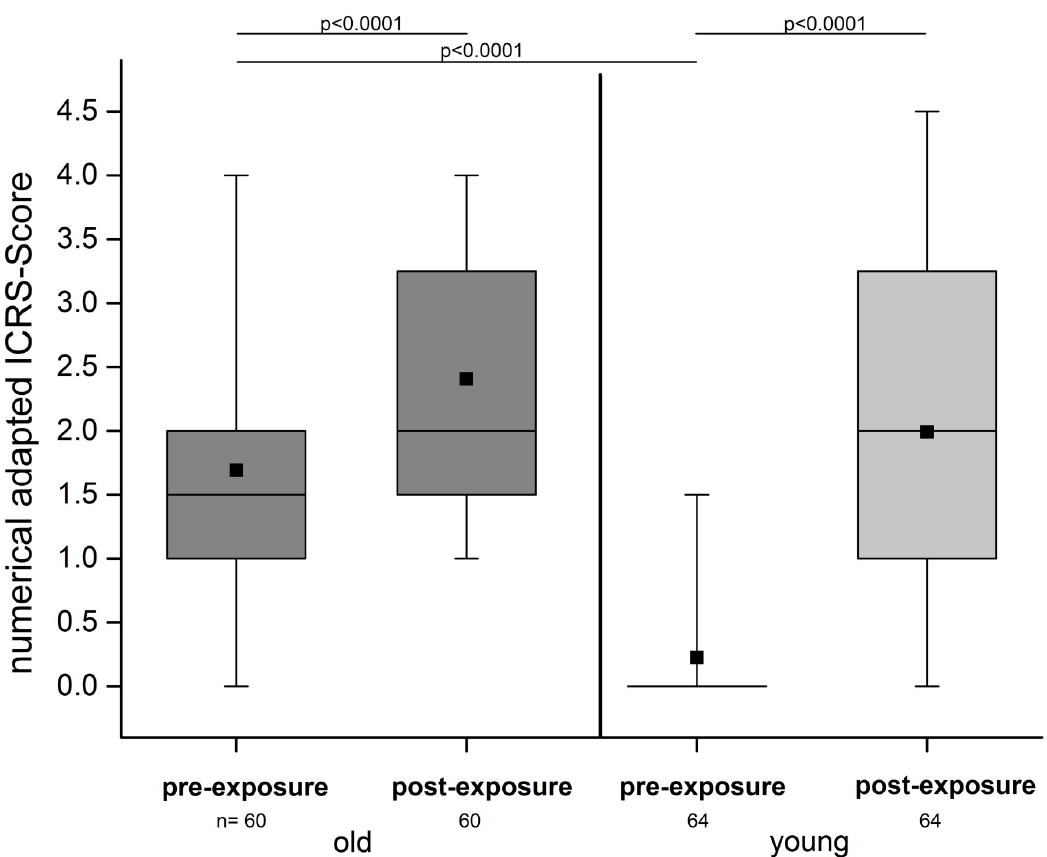
Fig 4. Numerically adapted ICRS-Score values before and after tribological exposure. On the left, the old group (dark grey) revealed medium score values of OA in the pre-exposure situation which were significantly increased after tribological exposure. The young group (light grey) on the right started with hardly any visible alterations and revealed significantly higher values after the exposure, similar to the conditions of the cartilage of the old animals after exposure (p = 0.0992).